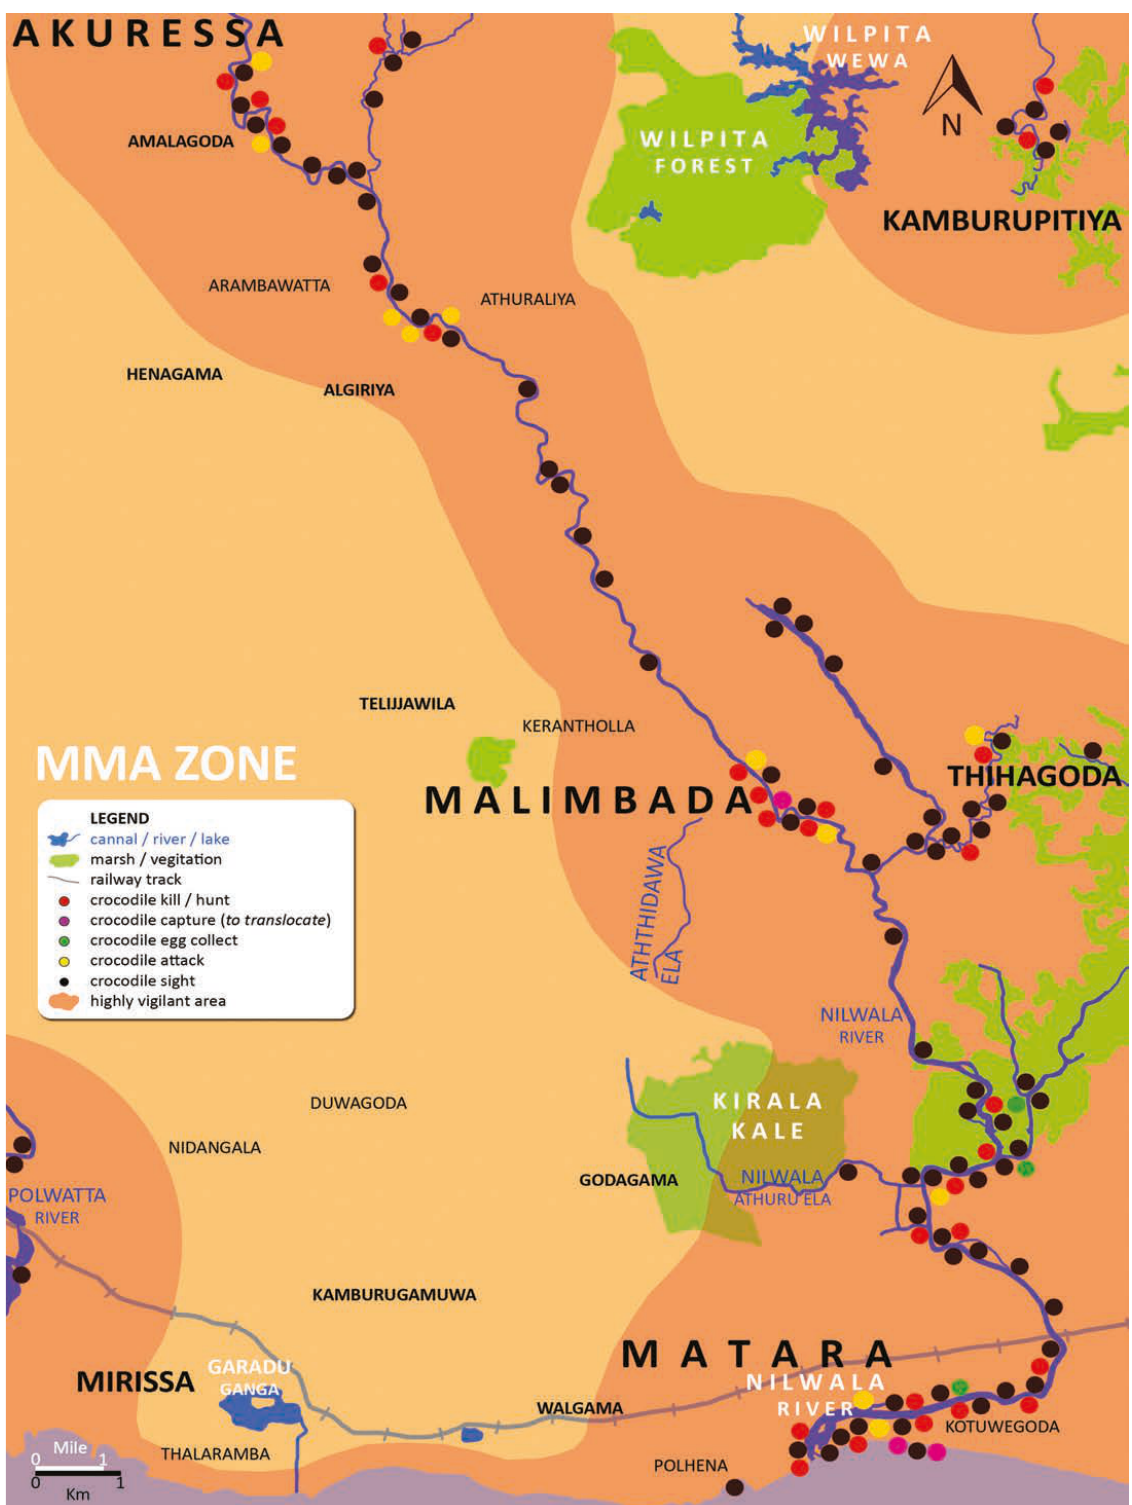
Image 2. Map of Matara–Malimbada–Akuressa Crocodile Vigilance Zone